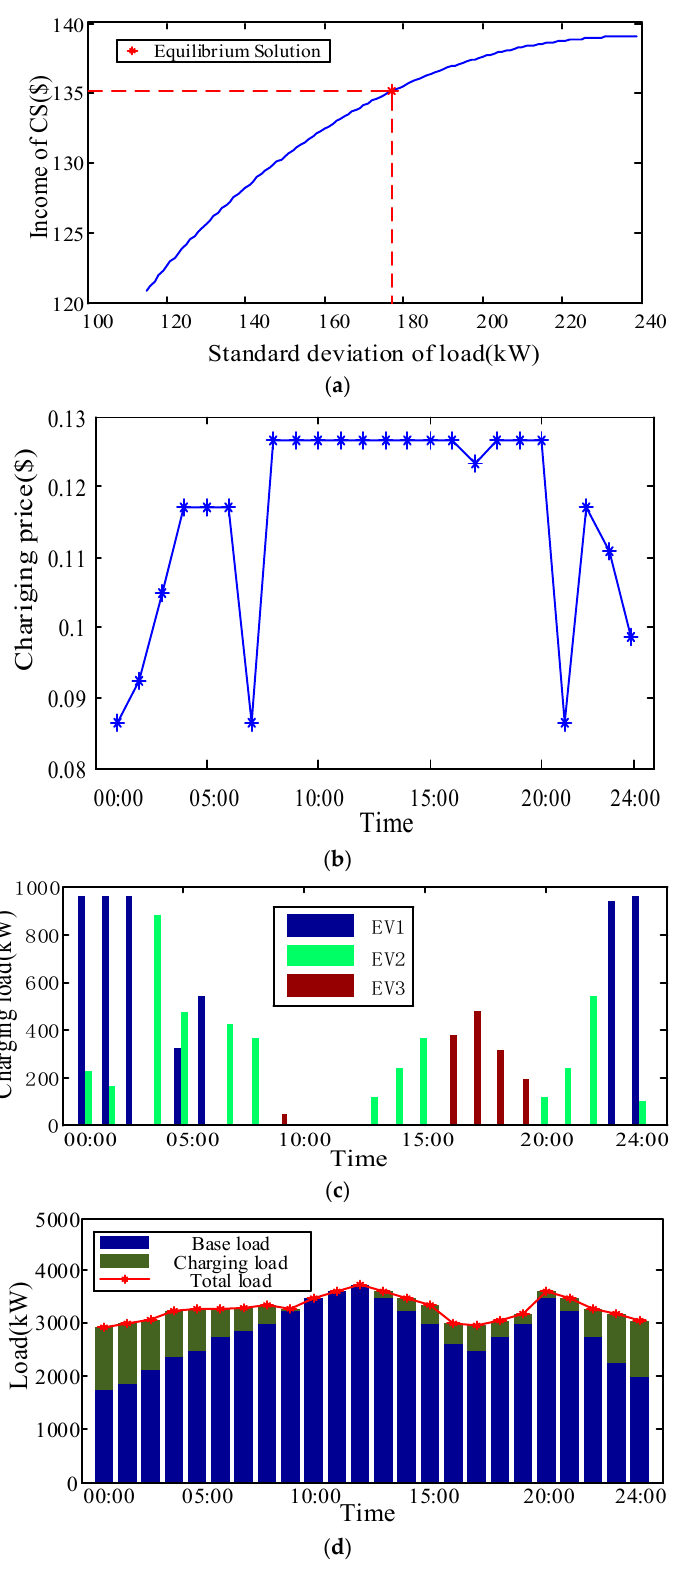
Figure 6. Simulation results. ( a ) shows the Pareto front. ( b ) shows the charging prices. ( c ) shows the charging load of charging stations. ( d ) shows the total load of distribution